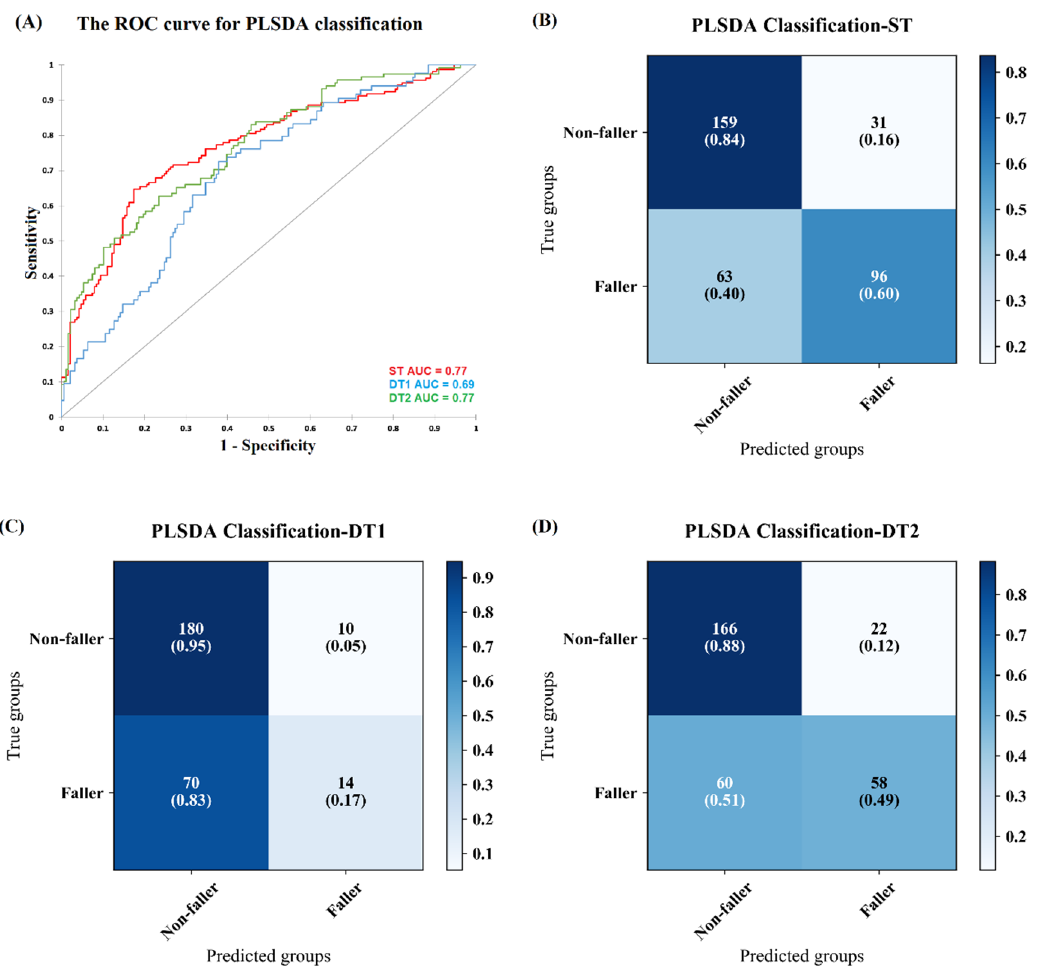
Figure 1. ( A ) shows the receiver operating characteristic (ROC) curves for partial least square discriminant analysis (PLS-DA) classification, based on ST (yellow), DT1 (green), and DT2 (blue) gait variables. ( B – D ) shows the classification matrix. The x-axis represents the participants in the predicted groups and the y-axis shows the participants in the original groups. The dark blue means more participants were assigned in this group. The numbers of participants and the percentages they occurred in the original group are shown in the squares and braces. DT1 = walking and checking boxes on a paper sheet; DT2 = serial 7 s subtraction.